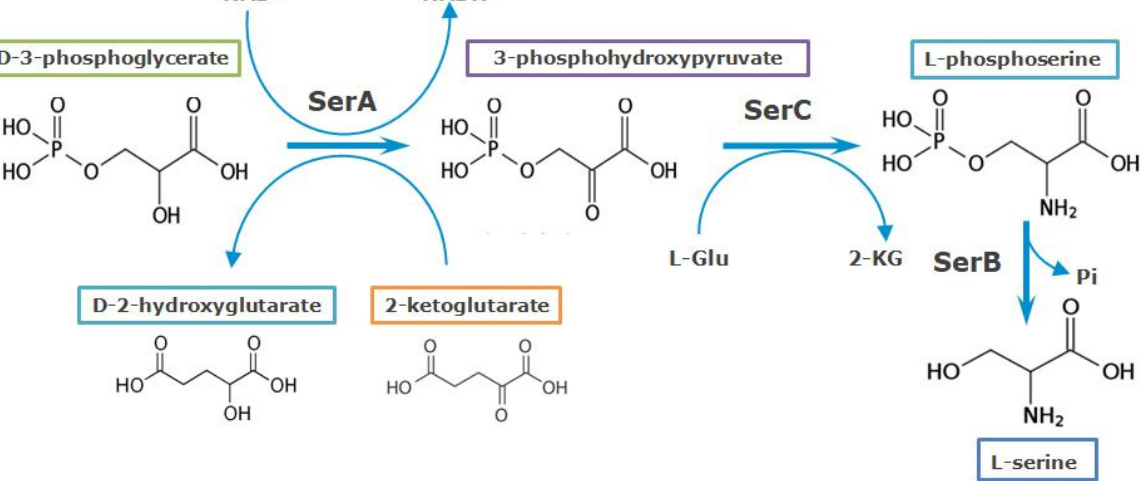
Figure 1. The pathway of L-serine biosynthesis in E. coli . 2-Ketoglutarate reductase activity of SerA is represented; P i —inorganic phosphate.